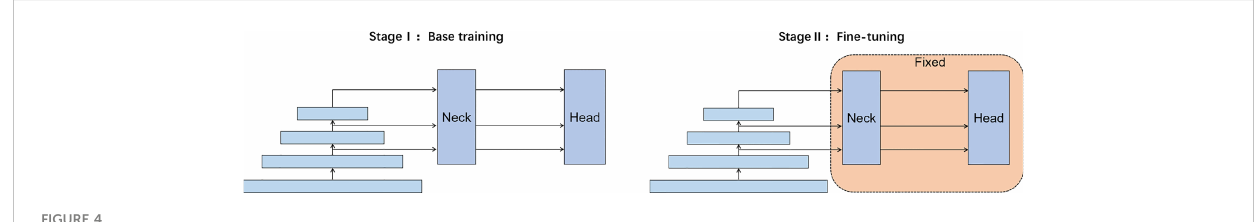
FIGURE 4 Our two-stage training